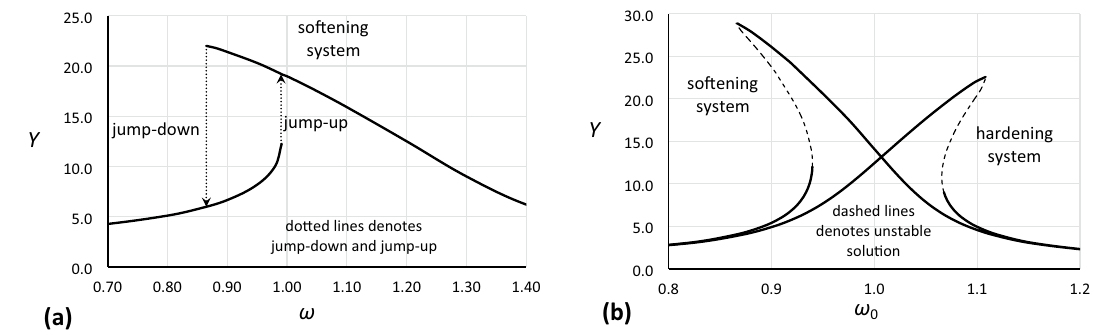
Figure 1. Frequency response curves determined from numerical simulations ( a ) and by analytical solution ( b